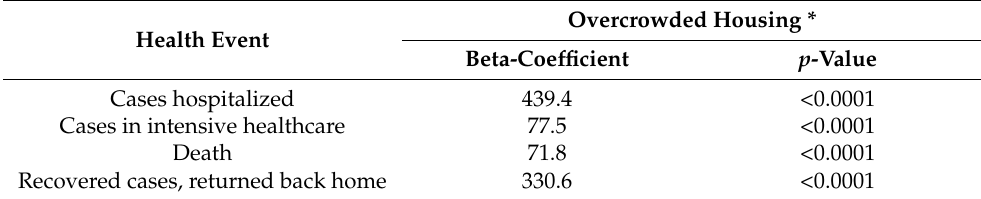
Table 1. Coefficient estimate of linear regression adjusted on the proportion of population aged over 60 years